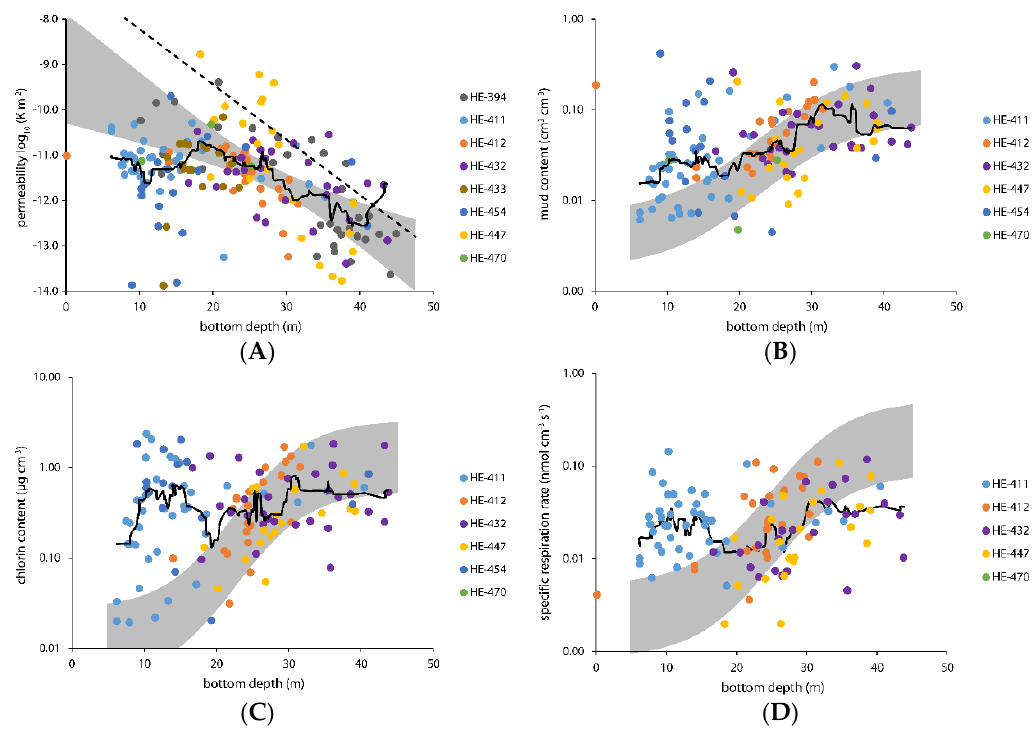
Figure 7. The correlation of the bottom depth with the ( A ) permeability, ( B ) mud content measured by laser diffraction, ( C ) chlorin content, and ( D ) specific respiration rate. The black line represents a 15-point running median. The black, dashed line in ( A ) indicates the assumed trend based on the grain size and bed shear stress considerations (see discussion). The gray bands indicate the confidence intervals of the null-hypotheses. The colors indicate the individual sampling cruises.